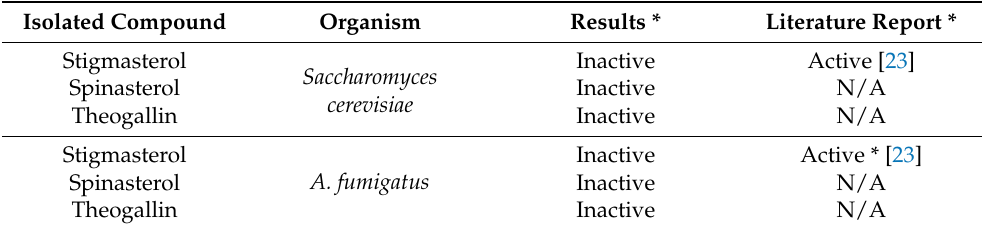
Table 5. The antifungal activity of the metabolites identified in the acetone extracts of Acacia ehrenbergiana . Isolated Compound